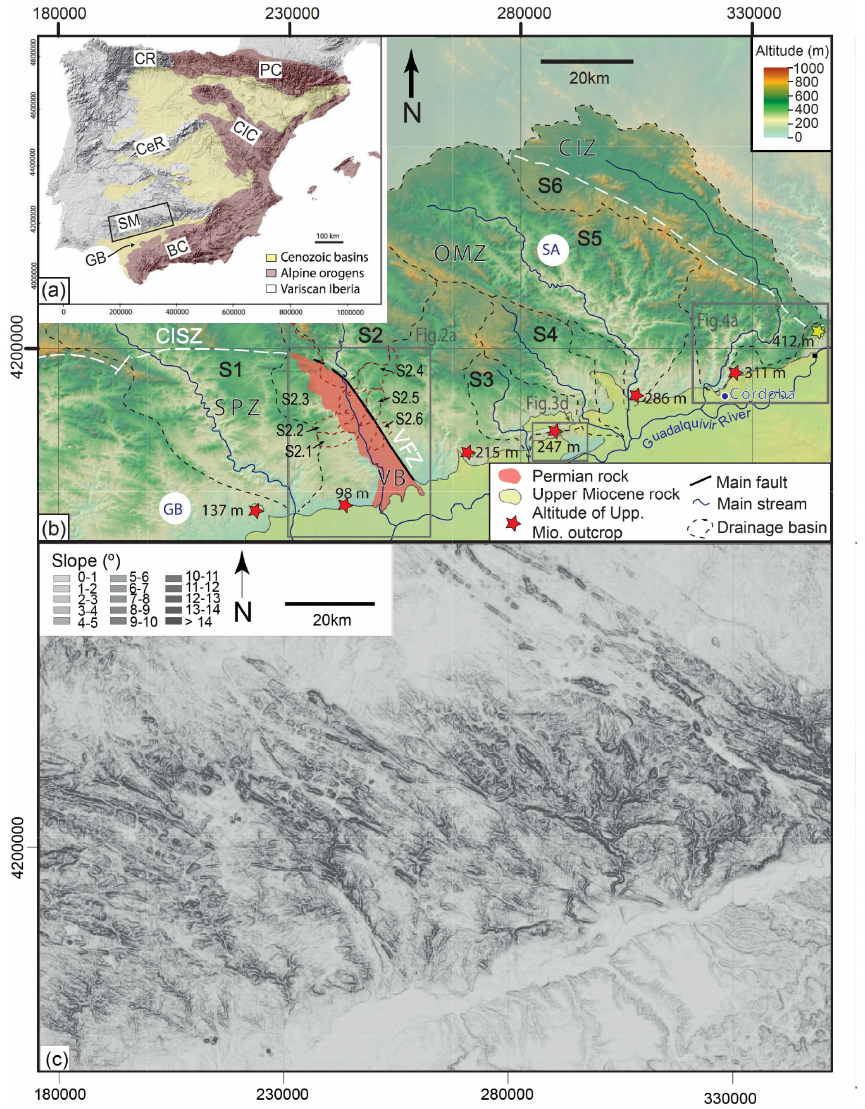
Figure 1. Location and topography of the study area. (a) Topographic domains of the Iberian Peninsula are related to following the main geological units: BC is the Betic Chain, GB is the Guadalquivir basin, SM is the Sierra Morena, CeR is the Central Range (or Central System), CR is the Cantabrian Range, CIC is the central Iberian Chain, and PC is the Pyrenean chain. (b) Altitude map of the study area (see the location in panel a ). S1 to S6 show the drainage basins analysed in this study (see the text for an explanation). S2.1 to S2.6 are the analysed sub-catchments of S2. OMZ is the Ossa-Morena zone, SPZ is the south Portuguese zone, VB is the Permian Viar basin, VFS is the Viar fault system, SISZ is the southern Iberian shear zone, GB is the Guadiamar basin, and SA is the Sierra Albarrana. (c) Slope maps of the same area. Note the preservation of low-slope relief surfaces on the interfluves of Sierra Morena. Maps in panels (b) and (c) are extracted from the digital elevation model (DEM) 12m resolution of TanDEM-X (Wessel, 2016). The reference system is WGS 84/UTM zone